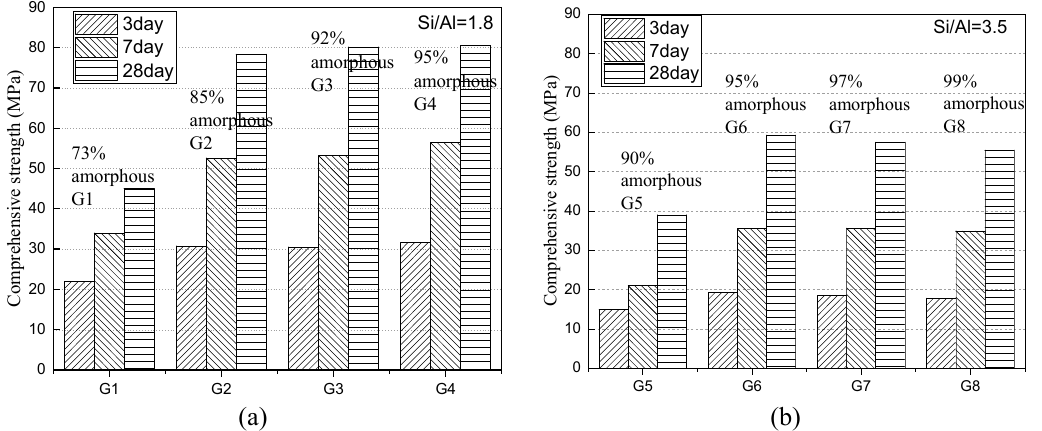
Figure 13. Compressive strength of blending paste with different amorphous contents slag at 3 d, 7 d, and 28 d ages